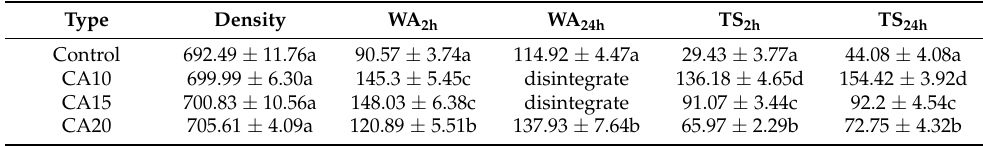
Table 1. Density, water absorption and thickness swelling of particleboard bonded with urea formaldehyde (UF) and different citric acid contents.